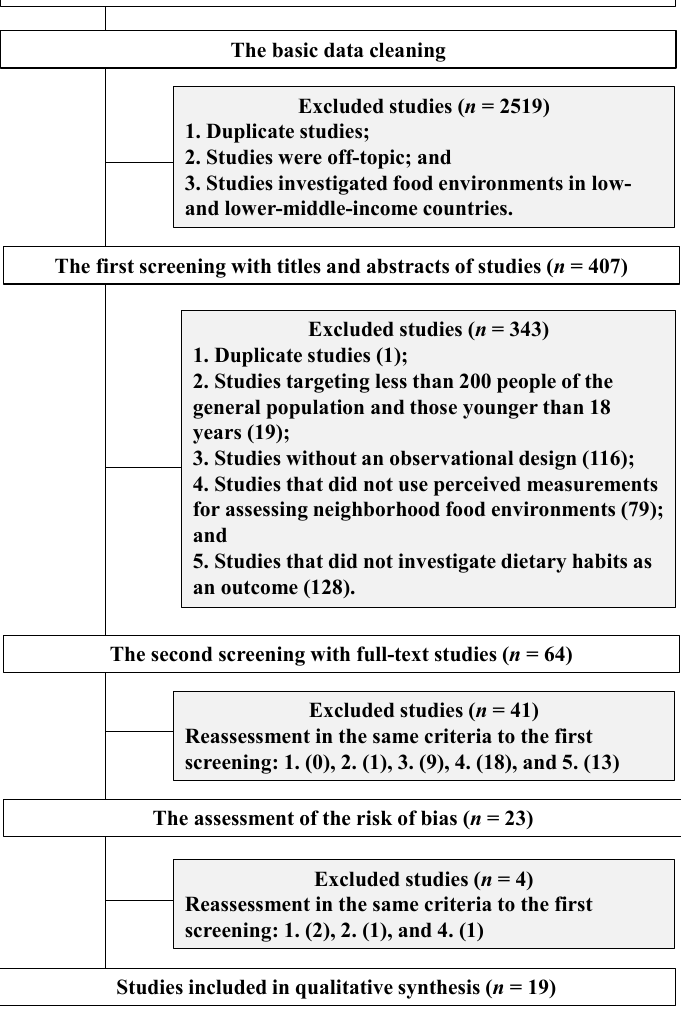
Figure 1. Flow chart of data extraction.